Question: What kind of plot is shown here?
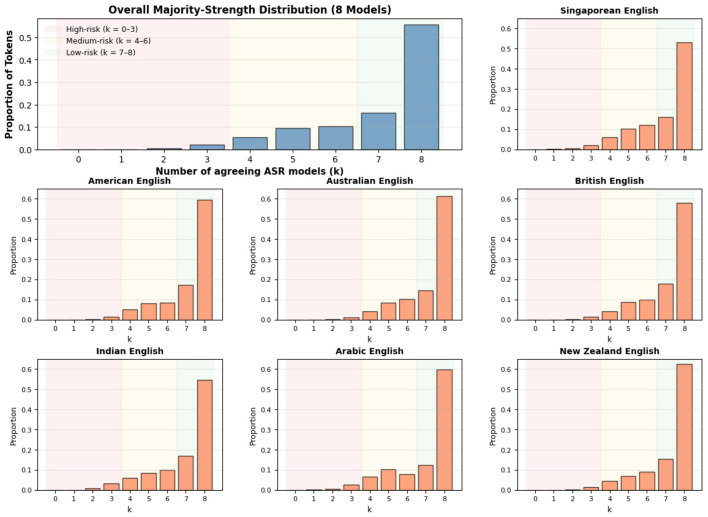
Answer: histogram